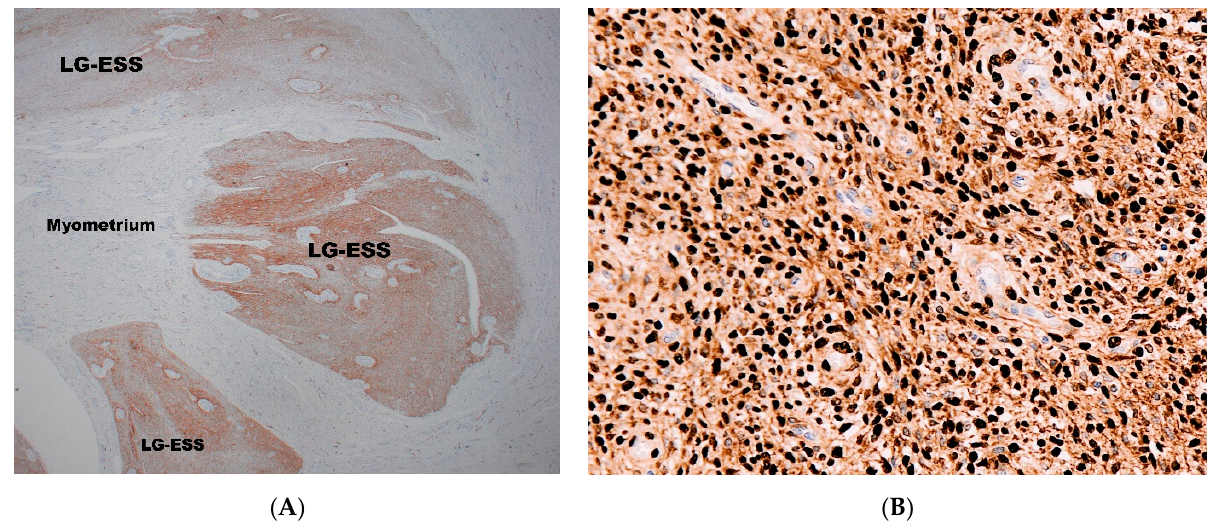
Figure 3. ( A ) Positive immunostaining with CD10 in LG-ESS; the surrounding myometrium is negative. ( B ) Diffuse strong nuclear immunoreactivity with ER in LG-ESS.